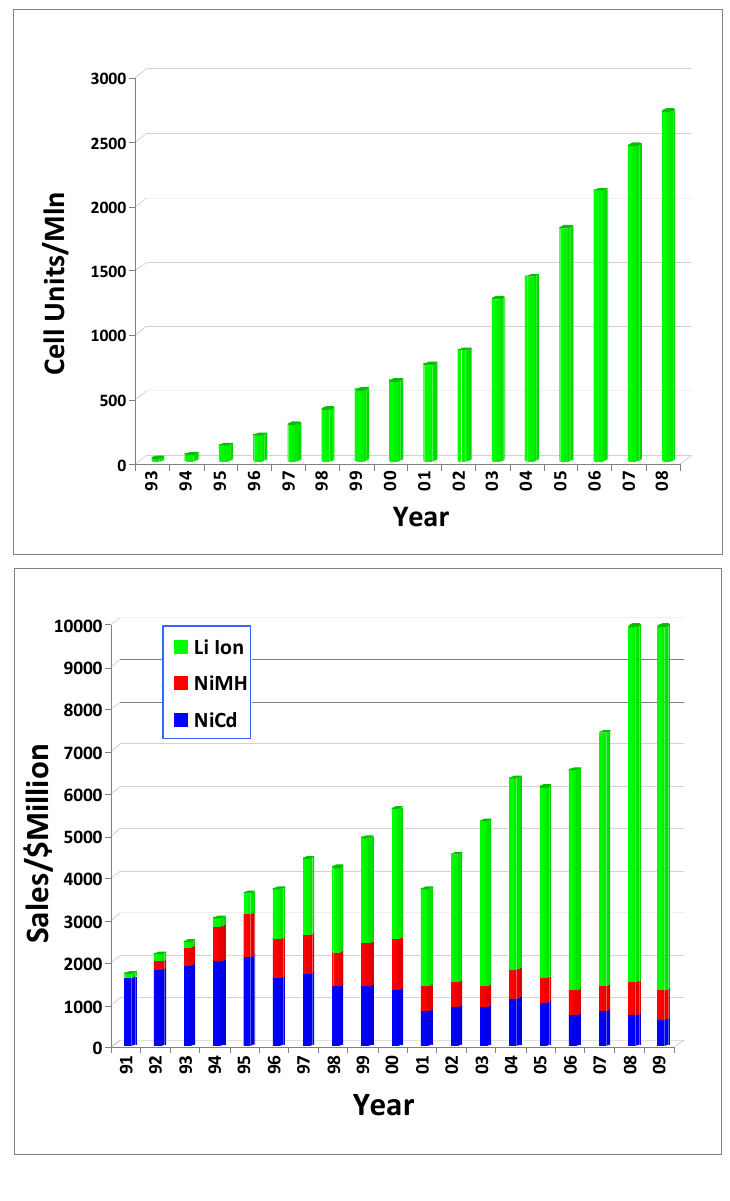
Figure 2. The steady growth of and rapid dominance by Li Ion batteries since its birth: (a) Li ion cell units manufactured per year; (b) sales comparison between Li ion batteries and the other two rechargeable chemistries (sources: (a) Battery Digest; (b) “Global and China's Li-ion Battery and Its Raw Materials Market Report, 2008–2009”, Market Avenue Inc., http://www.marketavenue.cn; (c)